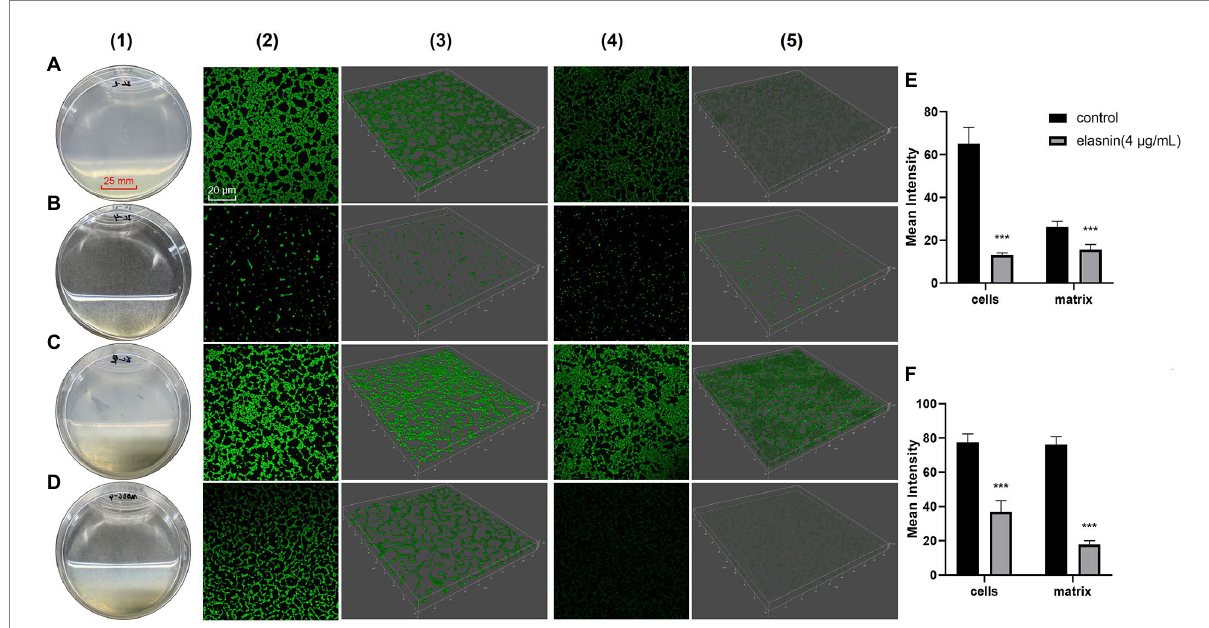
FIGURE 2 Comparison between the effect of elasnin on MRSA biofilm cells and matrix. (A) Image of the biofilms after incubation for 24 h (control). (B) Image of the biofilms after incubation for 24 h with 4 μ g/ml elasnin. (C) Image of the pre-formed biofilms after another incubation for 18 h (control). (D) Image of the pre-formed biofilms after another incubation for 18 h with 4 μ g/ml elasnin. (E) Quantitative analysis of confocal images acquired in biofilm-inhibition assay and (F) biofilm-eradication assay. Differences between different groups were calculated by Student’s t -test and are indicated by asterisks as follows: ***for p < 0.001. Series 1 show the images of biofilms under direct observation. Series 2 and 3 are the two-and three-dimensional confocal images of biofilm cells stained with FilmTracer ™ FM ® 1–43 green biofilm cell stain, respectively. Series 4 and 5 are the 2D and 3D images of biofilm matrix stained by FilmTracer ™ SYPRO ® Ruby Biofilm Matrix Stain, respectively. Confocal images were acquired under the same conditions, and quantitative analysis was conducted using Leica Application Suite X based on the relative fluorescence of 3D confocal